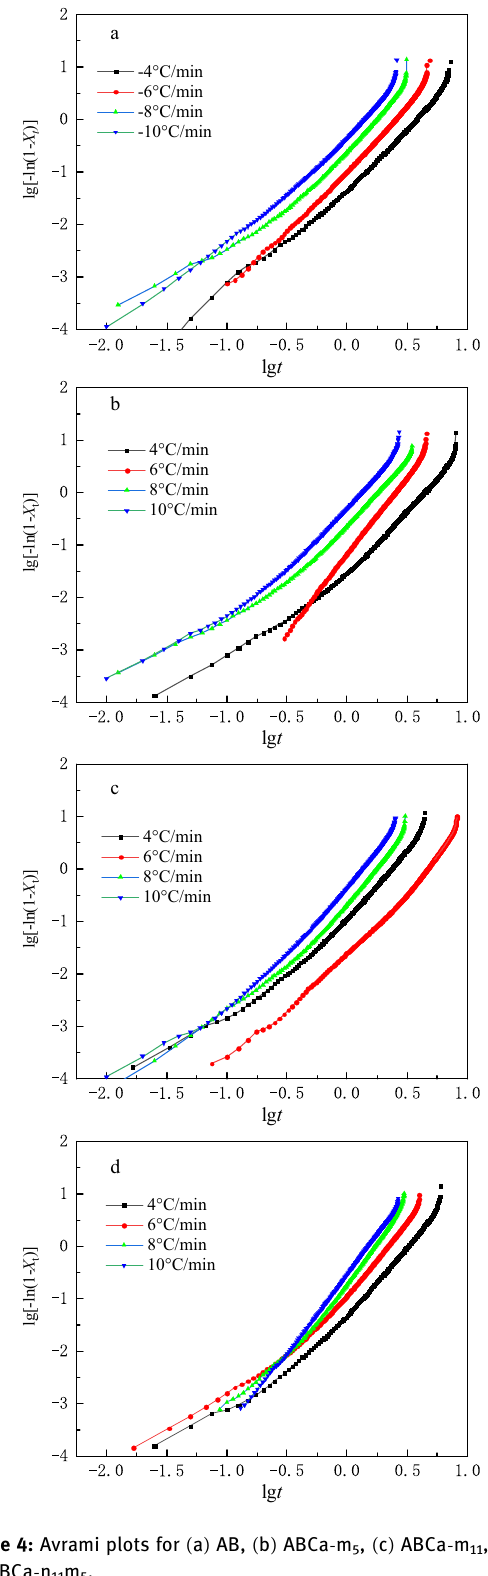
Figure 4: Avrami plots for ( a ) AB, ( b ) ABCa - m 5 , ( c ) ABCa - m 11 , and ( d ) ABCa - n 11 m 5